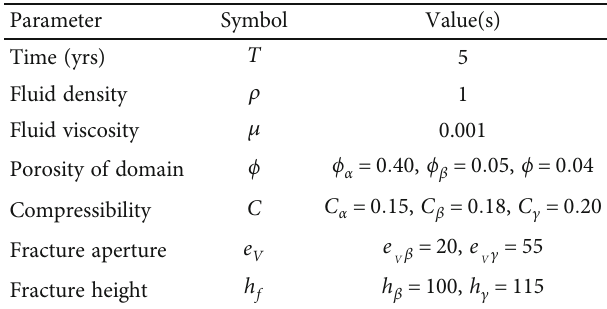
Table 1: Table of parameters used in the model and parameter values for simulation [12,